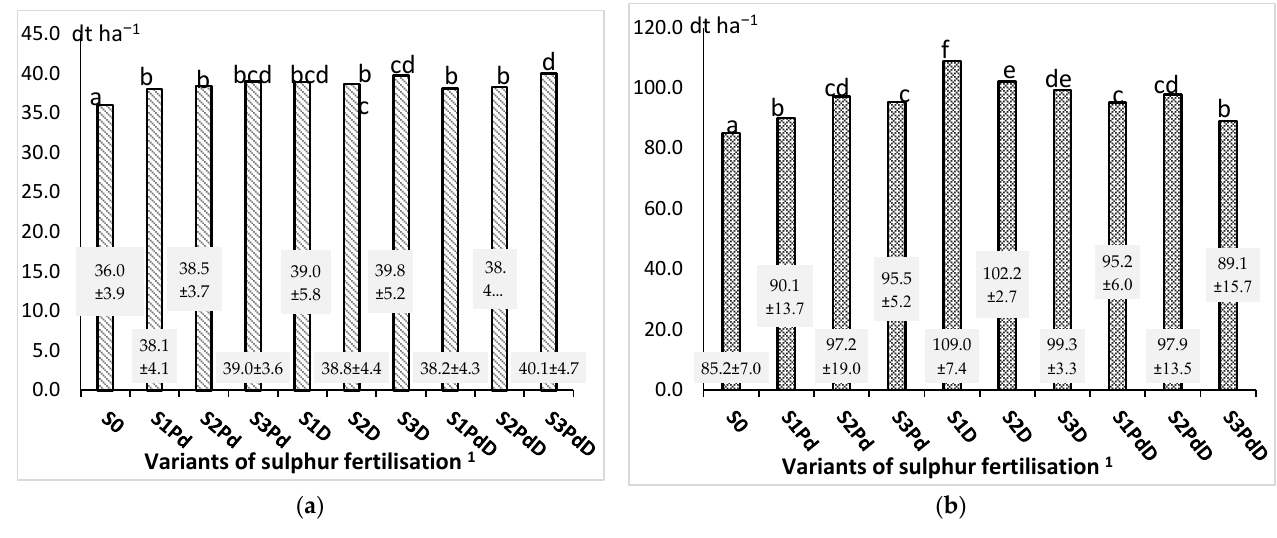
Figure 3. ( a ) Average yield of rape seeds for variants of sulphur fertilisation; ( b ) Average yield of rape straw for variants of sulphur fertilisation. 1 See Table 2; Means followed by the same letter are not statistically different at the α = 0.05 level. ± — standard deviation .